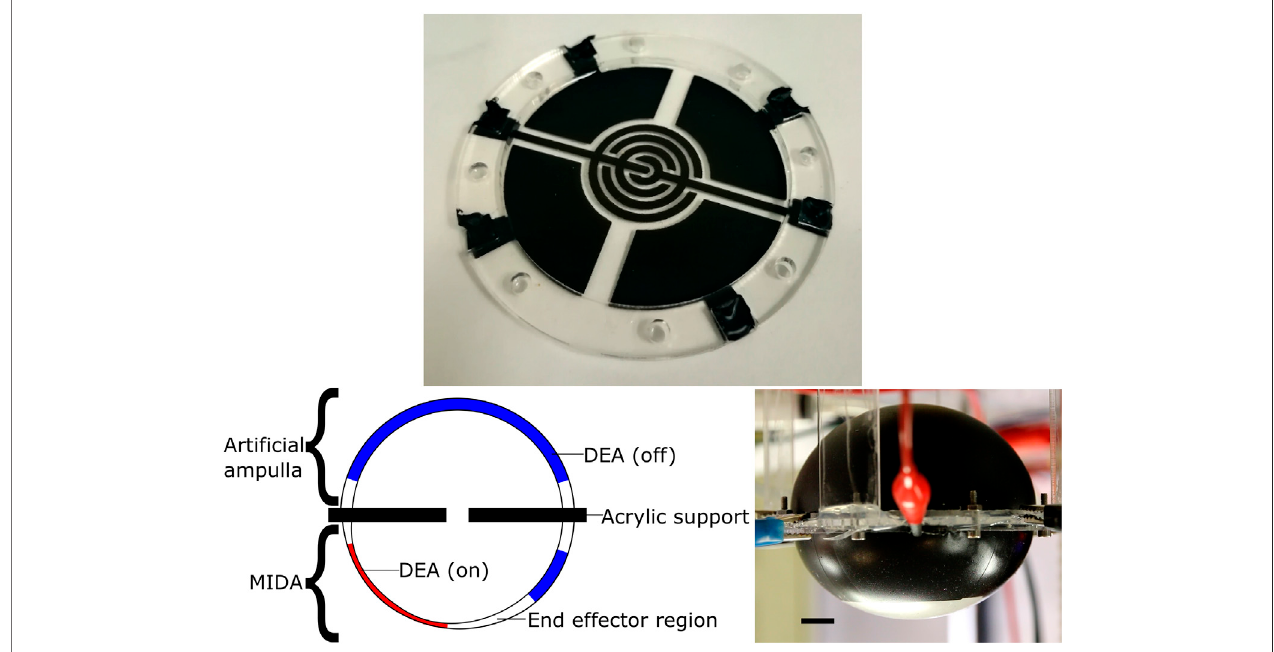
FIGURE 3 | Top: The top electrodes of a MIDA model, showing the 4 segmented actuators and an electro-adhesive end effector. Left: The structure of the MIDA arti fi cialtubefootactuator,in fl atedandundergoingactuation.Right:ThelatestprototypeMIDA,inverted.Blacklineis1 cminlength.See SupplementalMaterials fora video of the actuator in